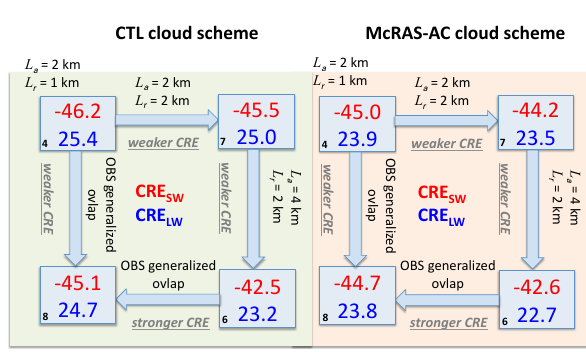
Fig. 4. CRE magnitudes for various decorrelation length values in the generalized overlap paradigm for the CTL cloud scheme (left) and the McRAS-AC cloud scheme (right). The numbers in the left bottom corner of the boxes are the experiment IDs according to Ta- ble